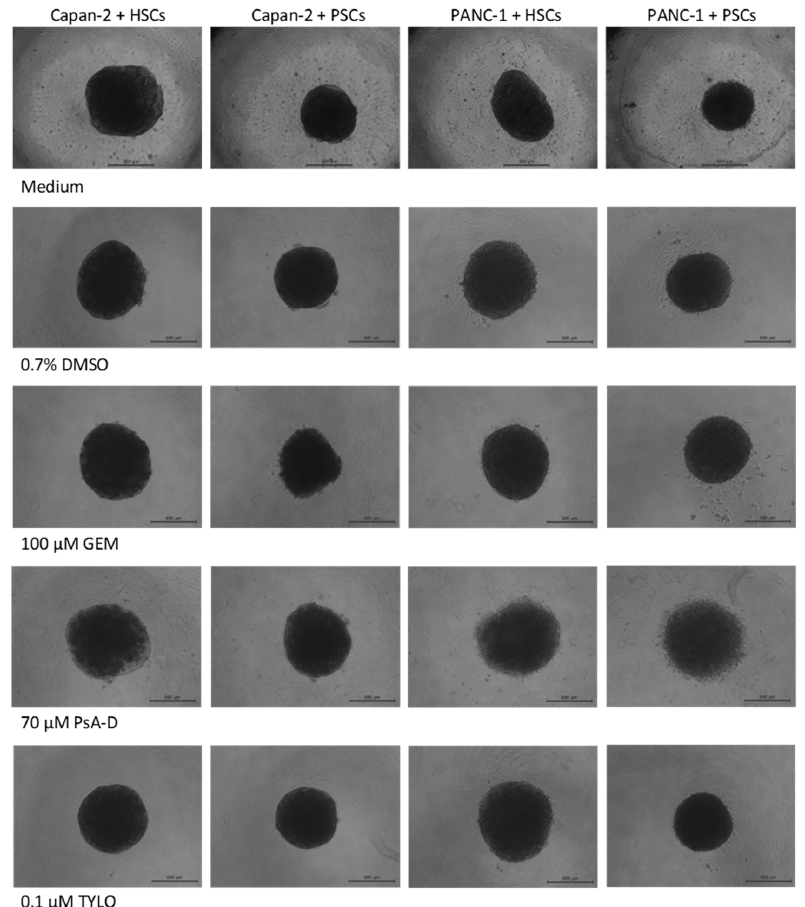
Figure 5. Phase-contrast images of the 3D spheroids prepared with 500 Capan-2 or PANC-1 cancer cells and 1000 hepatic stellate cells (HSCs) or pancreatic stellate cells (PSCs) in 50 µL of 0.1 mg/mL human type I collagen. After 4 days in culture, the spheroids were treated with medium, 100 µM gemcitabine (GEM), 70 µM pseudopterosin A-D (PsA-D), 0.1 µM O -methyltylophorinidine (TYLO), and 0.7% DMSO as a solvent control. After 3 additional days, the spheroid size and morphology were examined. Images are representative from at least three independent experiments with at least three spheroids in each experiment. Scale bar: 500 µm.